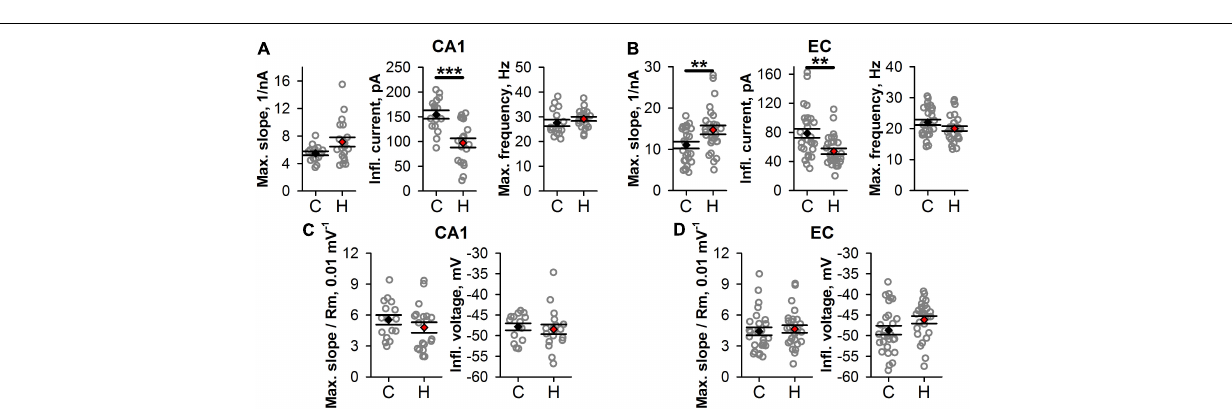
FIGURE 5 | Changes in firing properties of CA1 and EC neurons after prenatal hypoxia. (A) The voltage responses to 100 and 200 pA current steps in two representative CA1 neurons from control (CA1-Control) and hypoxic rats (CA1-Hypoxia). (B) The voltage responses to 55 and 110 pA current steps in two representative EC neurons from control (EC-Control) and hypoxic rats (EC-Hypoxia). (C) Plots demonstrating the average values of rheobase current parameters of CA1-neurons (left) and EC-neurons (right) in control (C) and hypoxic rats (H). Asterisks indicate a significant difference between groups according to an appropriate statistical test. ** P < 0.01, *** P < 0.001). (D) Representative examples of f/I curves for control (black) and post-hypoxia (red) neurons in CA1 and EC. The data were fitted with the Gompertz function (Eq. 1, thin solid lines).